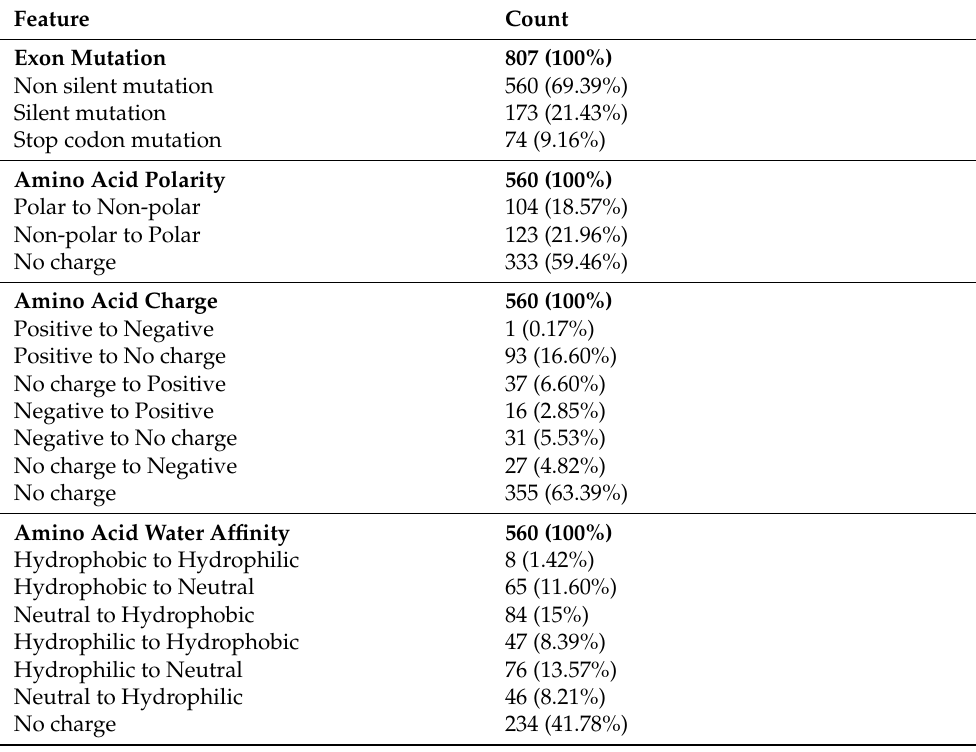
Table 2. Data summary for the exon mutation samples used in this study from TCGA, UK BioBank and cBioPortal datasets to analyse the mutation impact at protein structure and function. Including amino acid polarity, charges and water affinity.